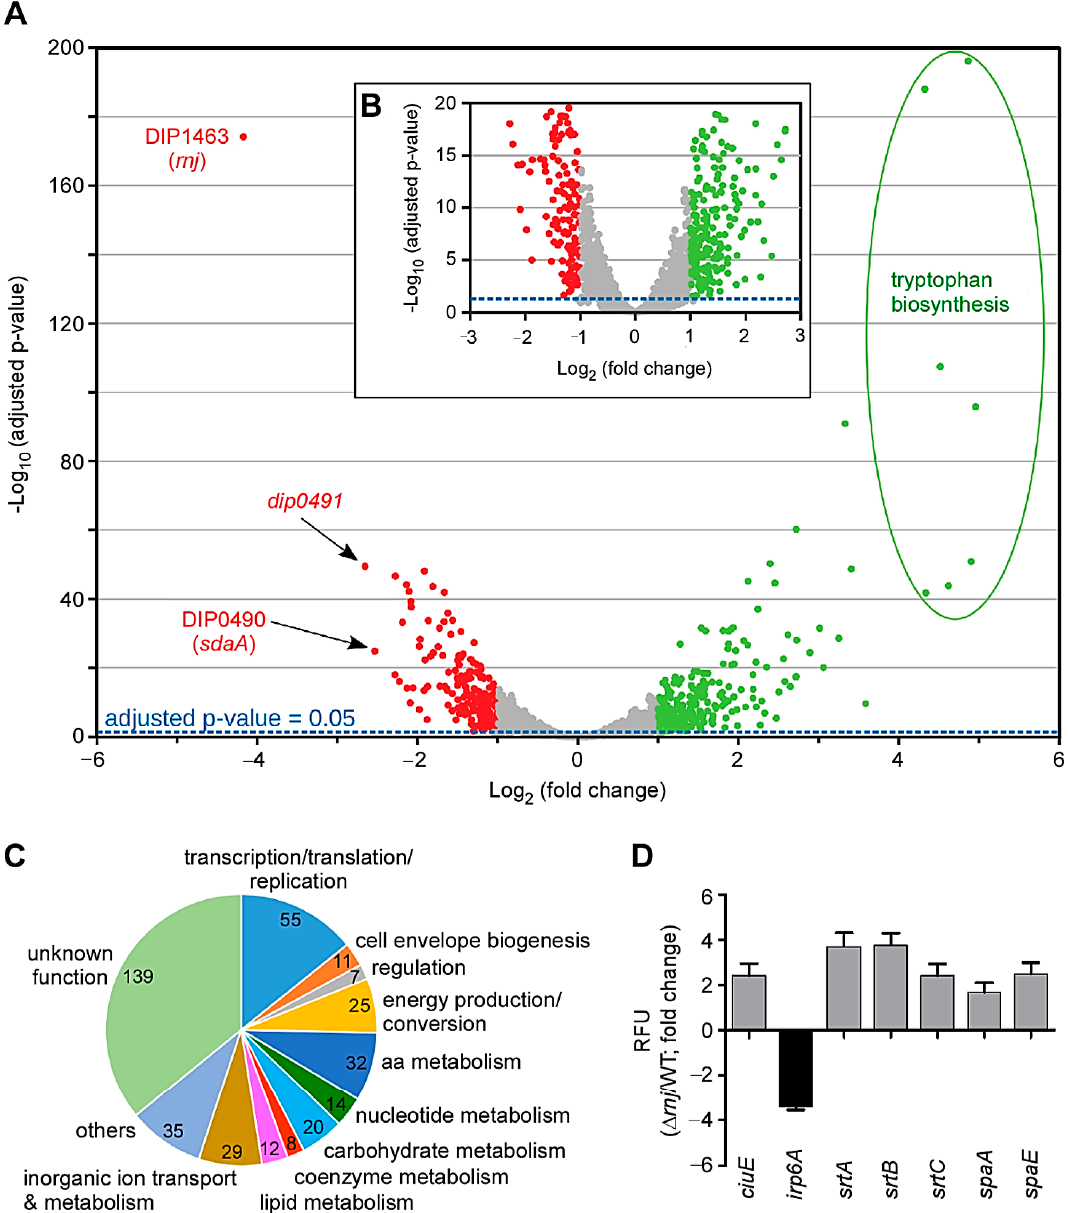
Figure 3. RNA-Seq analysis of the ∆ rnj mutant. ( A ) Presented is a volcano plot of differentially transcribed genes in the ∆ rnj mutant. The log − log 2 (fold change) (LFC) was plotted against the statistical significance ( 10 of the adjusted p -value) for each gene. The dashed blue line indicates the negative log 10 of the adjusted p -value of 0.05. All genes above a LFC of +1.0 and below − 1.0 are colored in green and red, respectively. Genes predicted to be involved in tryptophan biosynthesis are encircled. Three genes, including the remaining part of the rnj transcript in the rnj deletion mutant, are labeled in red. ( B ) This insert represents a detail of the volcano plot to better indicate the position of the adjusted p -value of 0.05 (dashed blue line). ( C ) Differentially regulated genes with similar categorical functions based on clusters of orthologous groups are shown in a pie chart. ( D ) Some differentially regulated genes in the RNA-seq analysis were confirmed by RT-PCR using RNA samples collected from mid-log phase cells; 23S rRNA was used as